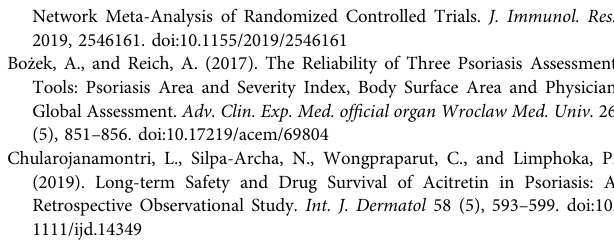
Supplementary Figure S1 | The fl ow chart of the study of this